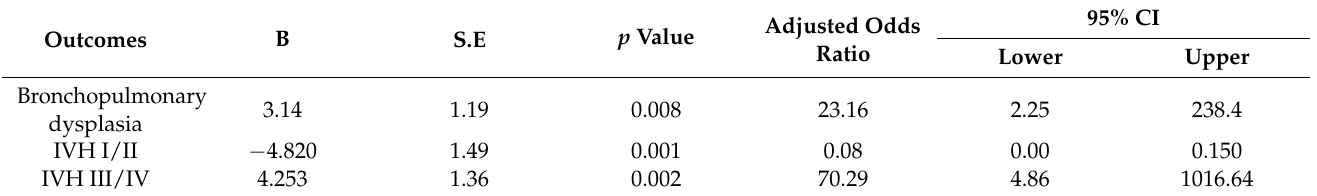
Table 8. Likelihood of fetal outcomes among infants delivered under 30 WG in the control group, on multivariate